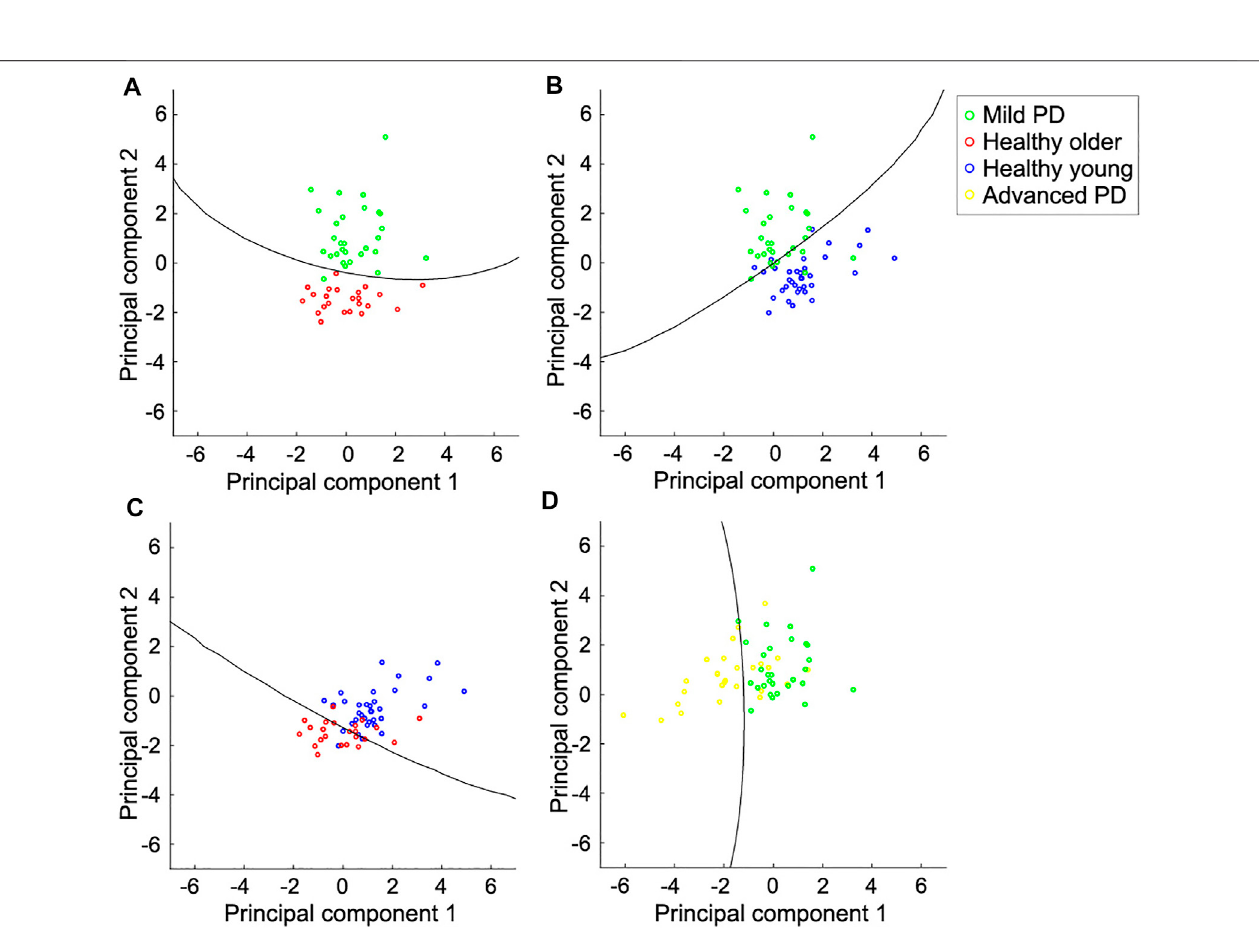
FIGURE6| Scatterplotforpairsofindividualcategoriesandboundariesusingthe fi rsttwoprincipalcomponents. (A) MildPDpatientsandhealthyolderindividuals. They are mainly distinguished by the second principal component, which represents the vertical displacements in the foot trajectory. (B) Mild PD patients and healthy young individuals. They are distinguished by both components. The foot trajectory of the mild PD patients tended to be larger in the vertical direction and smaller in the forward direction than in healthy young individuals. (C) Healthy older individuals and young individuals. They are also distinguished by both components. The foot trajectory of the healthy older individuals tended to be shorter in both directions than in healthy young individuals. (D) Mild and advanced PD patients. They are mainly distinguished by the fi rst principal component, which represents the forward displacements. Each circle represents one subject, and the lines represent the boundaries between the two